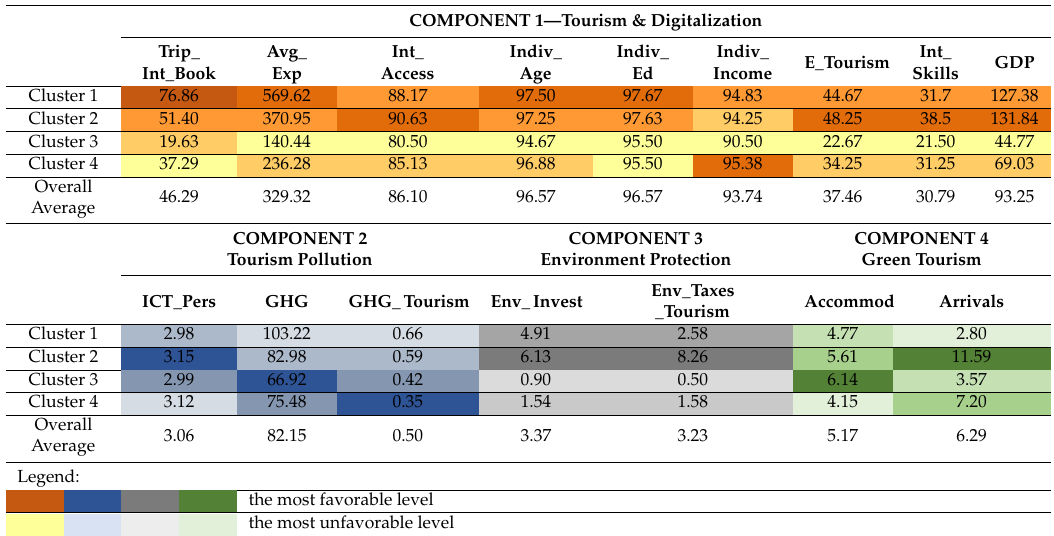
Table 8. Cluster characterization according to hierarchical classification criteria. Source: Authors’ own contribution, based on data provided by